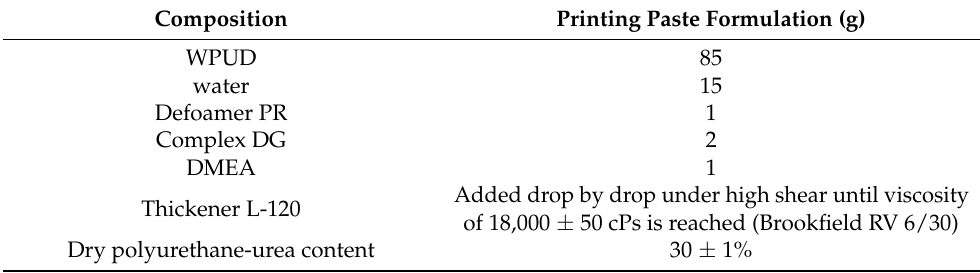
Table 2. Printing paste formulation employed to perform the coating of the fabrics with the